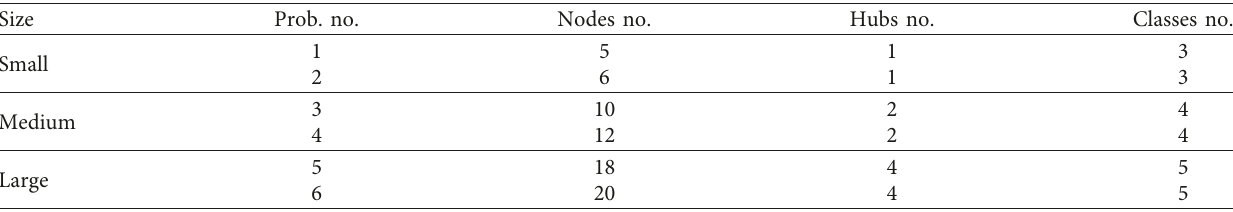
Table 3: Sample problems dimension.